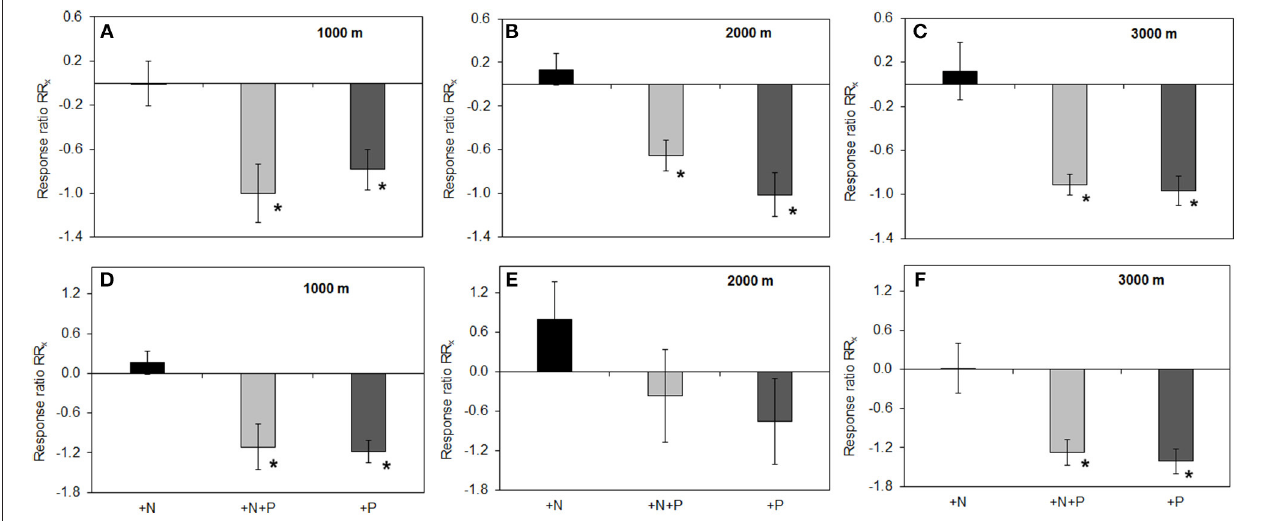
FIGURE 3 | Effects of nutrient addition on specific phosphomonoesterase activity in soil. RR x -values are given for phosphomonoesterase (A–C) and phosphodiesterase (D–F) in the organic layer of all altitudes (A) 1000, (B) 2000, (C) 3000 m, and mineral soil (D) 1000, (E) 2000, (F) 3000m. For illustrational details, see caption of Figure 2 . Asterisks indicate values significantly different from zero ( t -Test, P < 0.05 ).